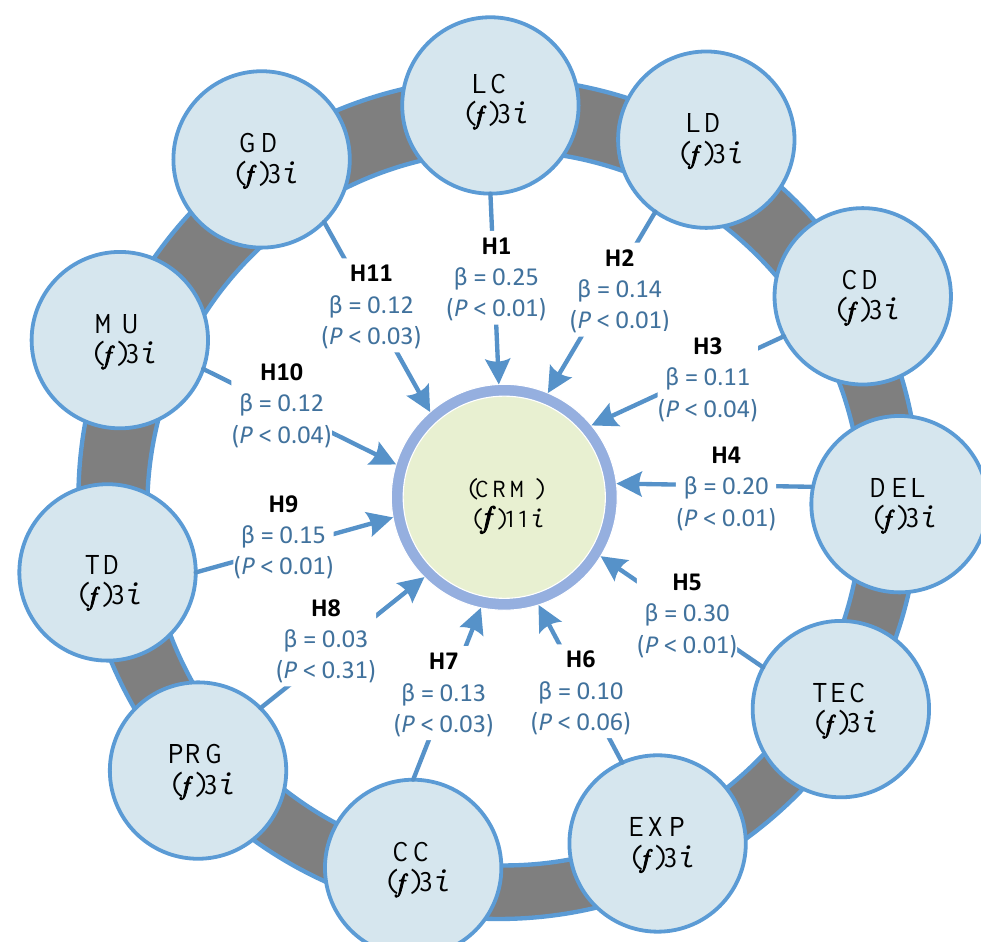
Figure 5. A conceptual framework with hypothesis testing.